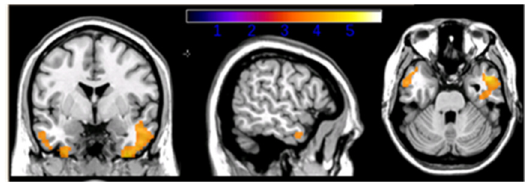
Figure 1. Interaction between education and A β 1-42 values in AD patients’ groups, p < 0.05 level [73].